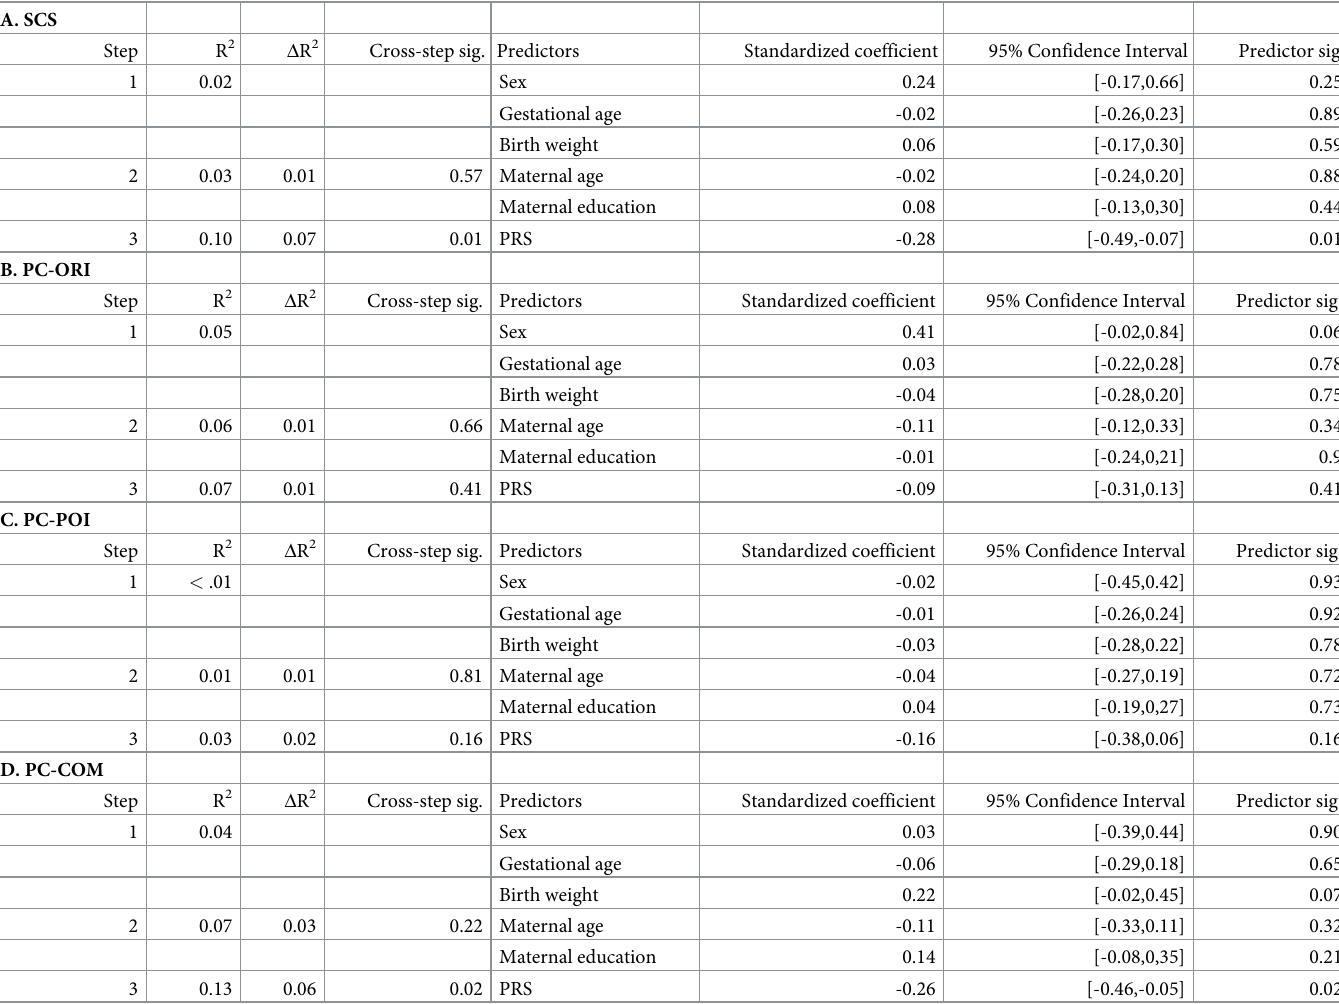
Table 4. Hierarchical regression models testing the effect of maternal PRS on infants’ socio-cognitive development at 12 months (N =